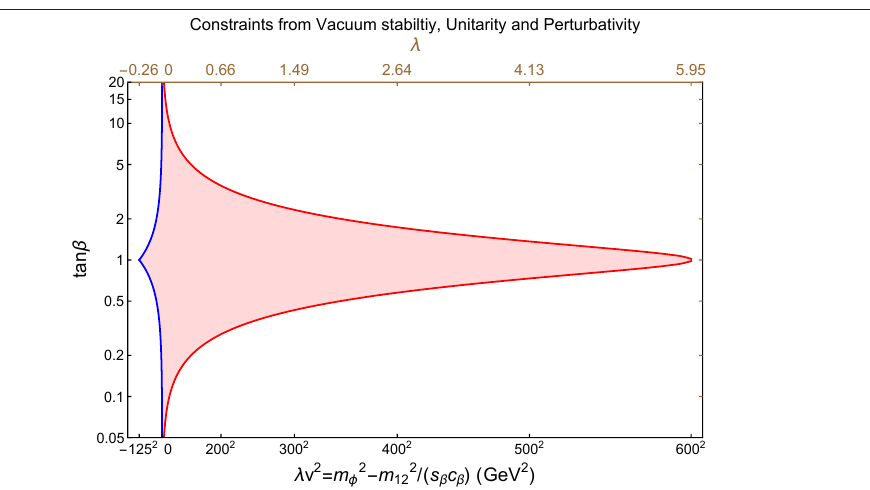
Figure 2. The shaded region indicates the surviving region of 2HDM parameter space of t β vs. λv 2 , after vacuum stability (blue lines) , unitarity and perturbativity (red lines) are taken into account at leading order. The corresponding values of λ are shown in the upper axis. We assume that m H ± = m H = m A ≡ m φ , and also that the alignment limit of c βα = 0 is